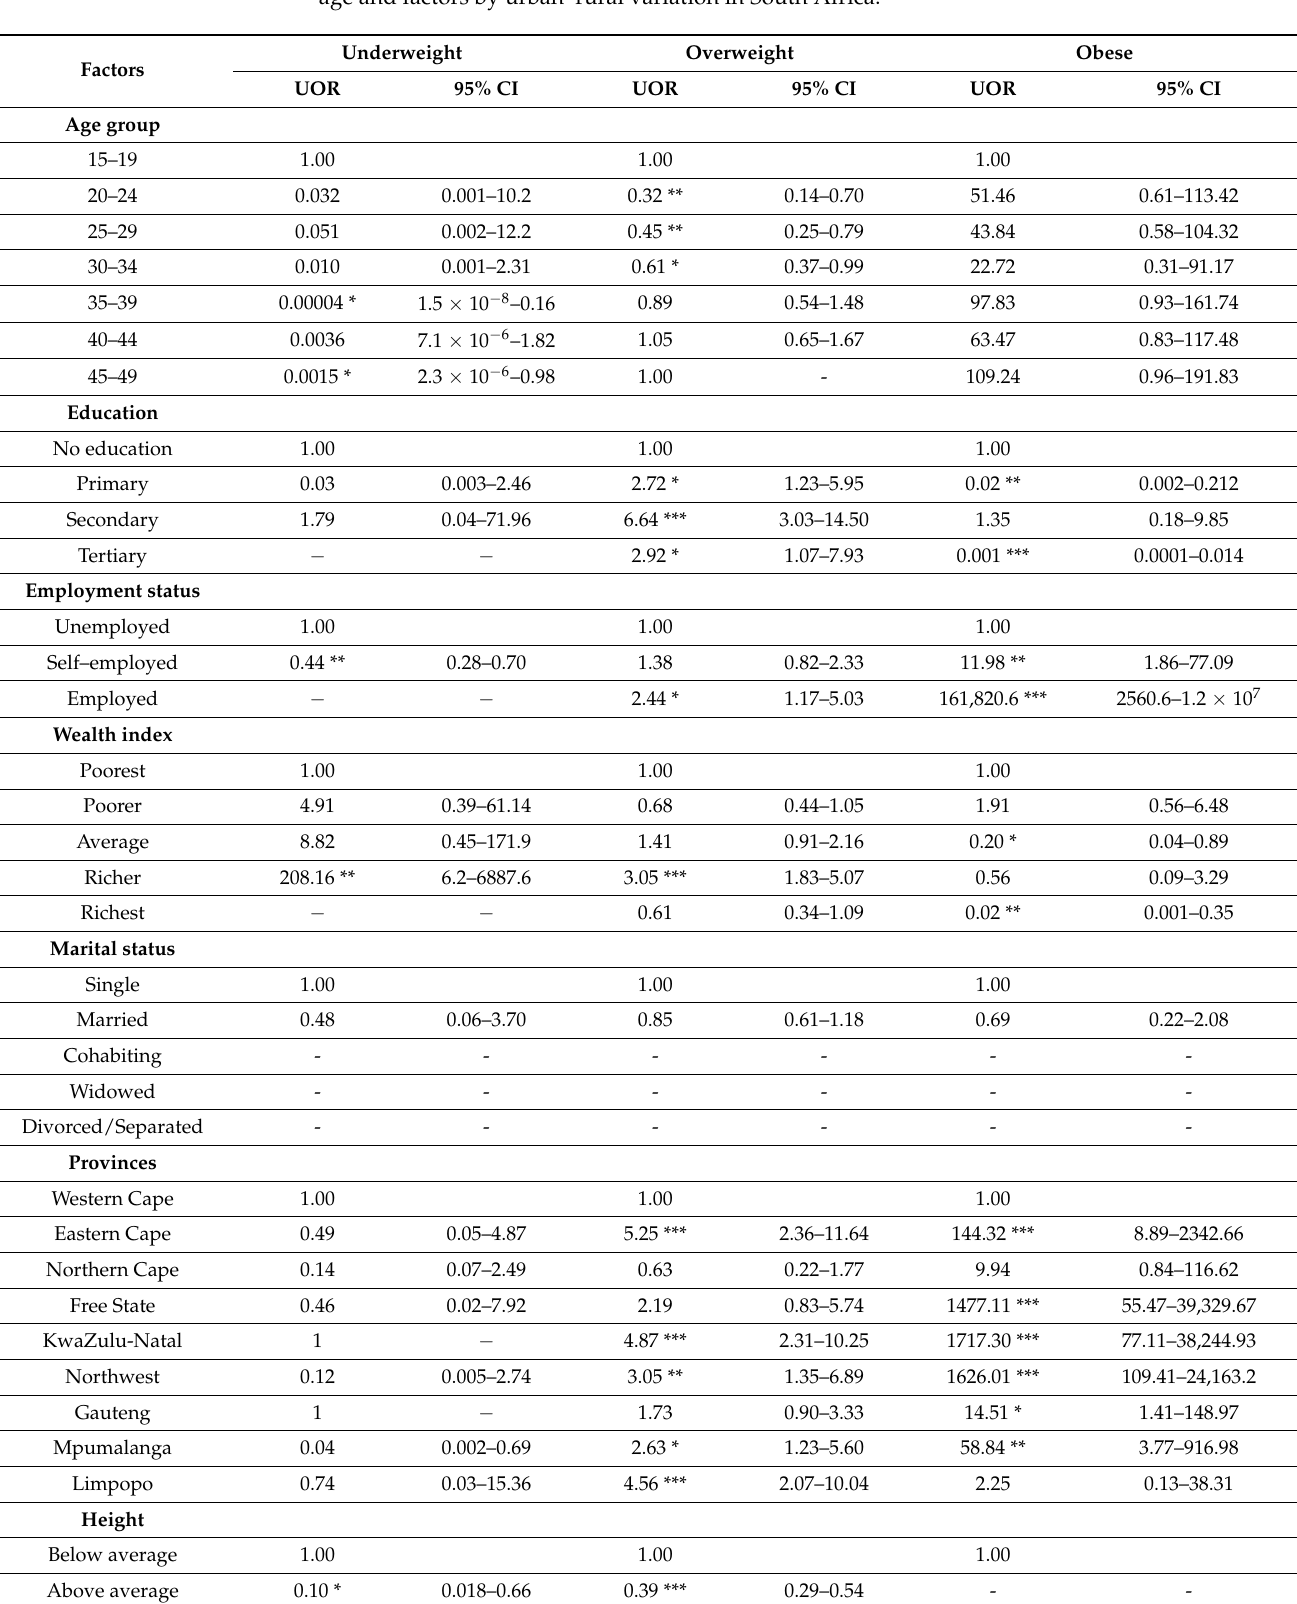
Table 6. Multi-level analysis showing the predictors of body weight among women of childbearing age and factors by urban–rural variation in South